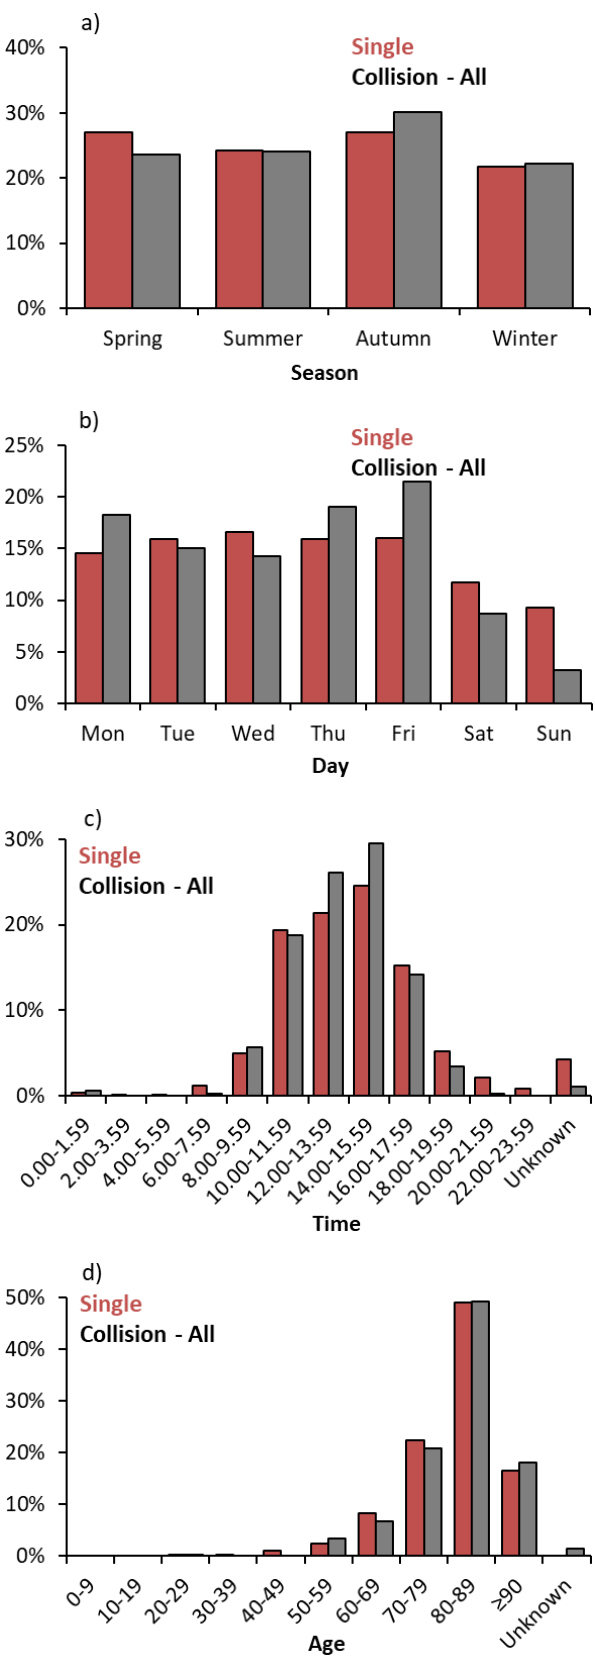
Figure 6. The distribution of a) season, b) day, c) time, and d) age of the driver in PMD single accidents (in red, n=1,668) and collisions (in grey,